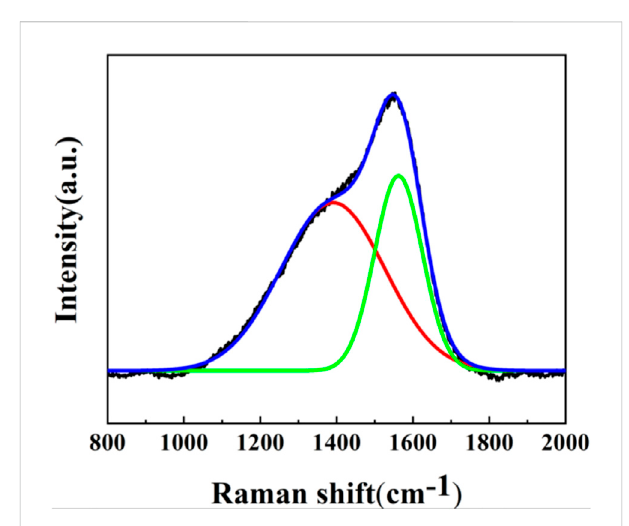
FIGURE 13 Raman spectra of the grinding ball with samples treated with 3.0 A current under 8